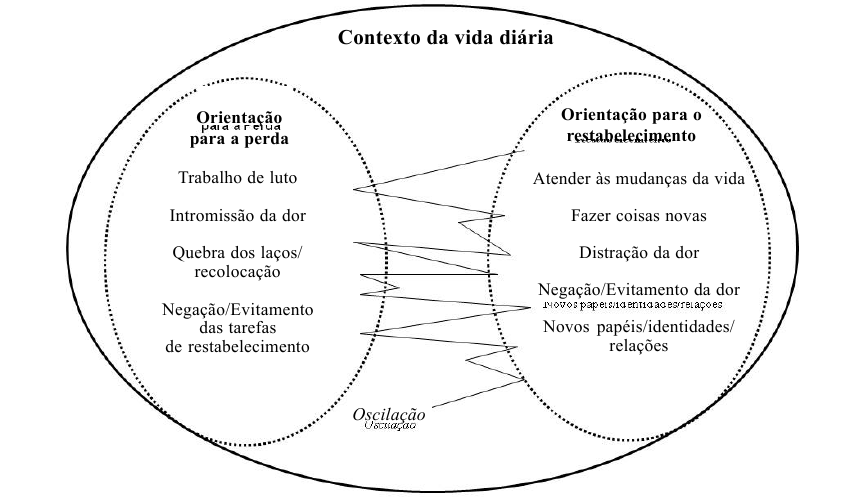
Figura 1 . Processo Dual de Lidar com o Luto (Hansson & Stroebe, 2007) 1